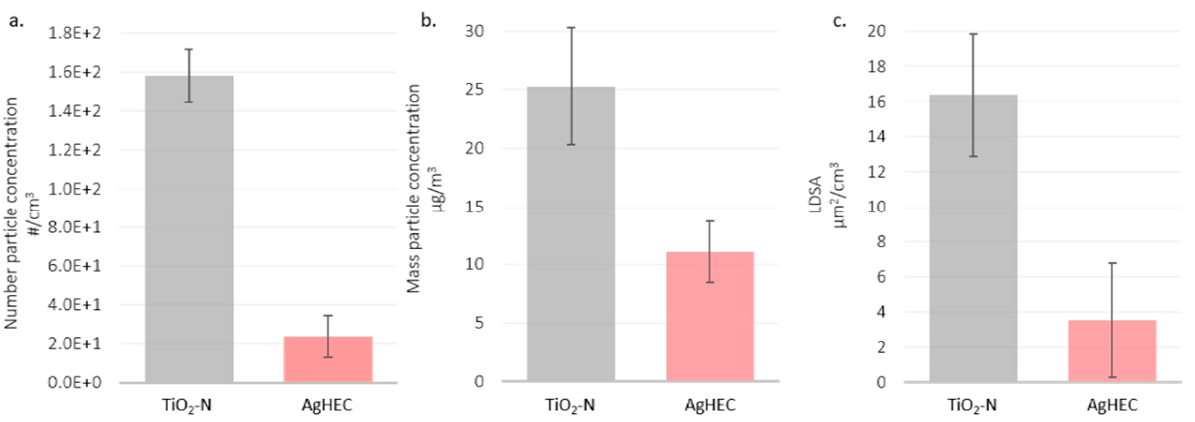
Figure 11. Histograms of T5 and T12 compared in the NF station: ( a ) particle number concentration